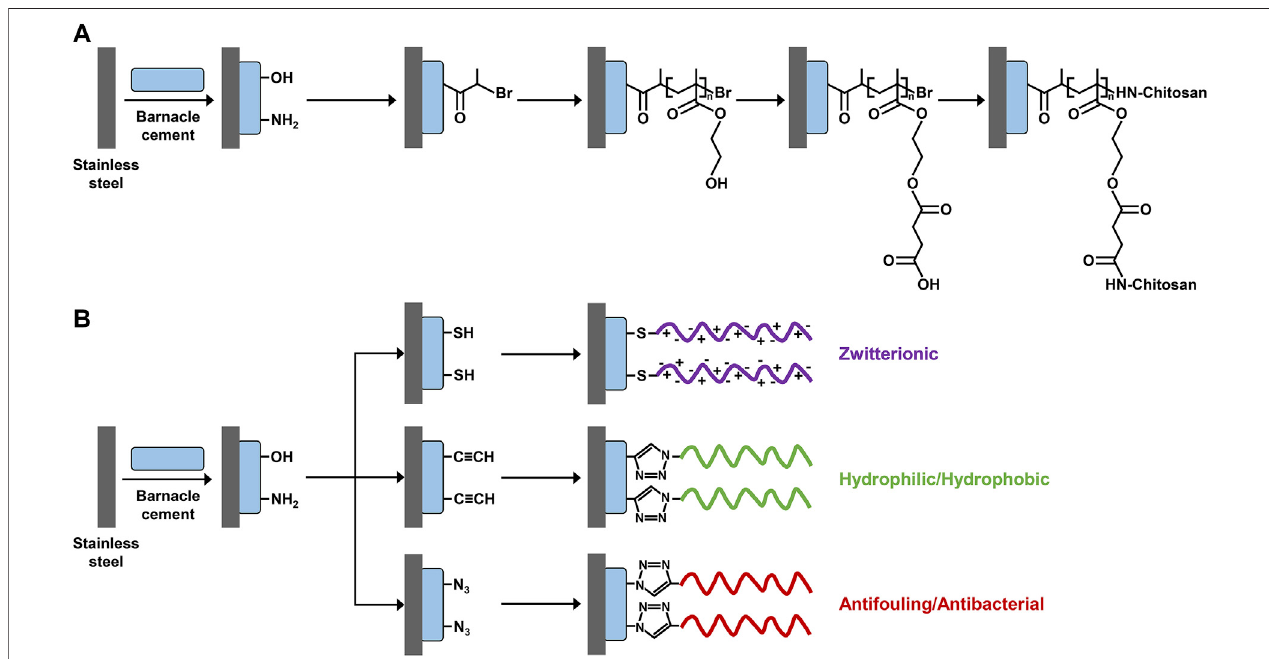
FIGURE 2 | Scheme of surface modi fi cation using barnacle cement as a biomimetic anchor. Collected fresh liquid barnacle cement is fi rst coated on a stainless steelpaneltointroduceabundanthydroxylandaminegroups.Then,differentfunctionalpolymerbrushstructuresareconstructedonthestainlesssteelpanelthrough (A) surface-initiated atom transfer radical polymerization and (B) click chemistry. (A) Adapted with permission from Yang et al. (2011). Copyright 2011, American Chemical Society. (B) Adapted with permission from Yang et al. (2013). Copyright 2013, American Chemical